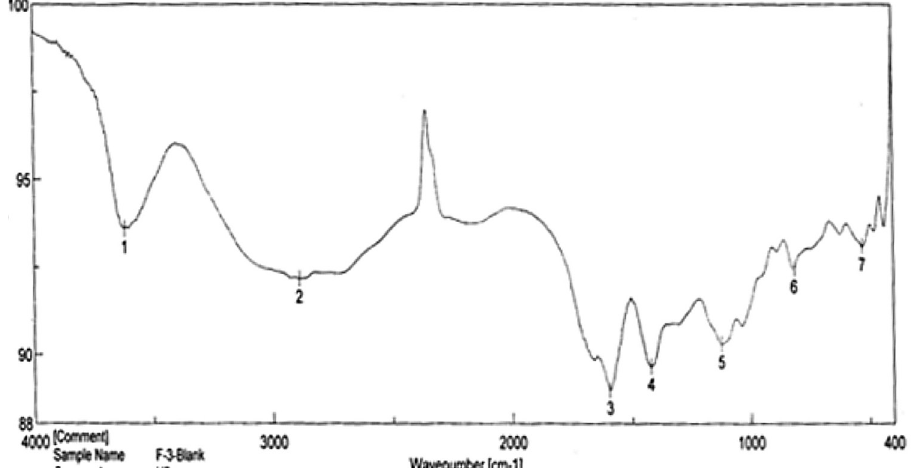
FIGURE 7 (e) - FTIR Spectroscopic analysis of formulation F2.